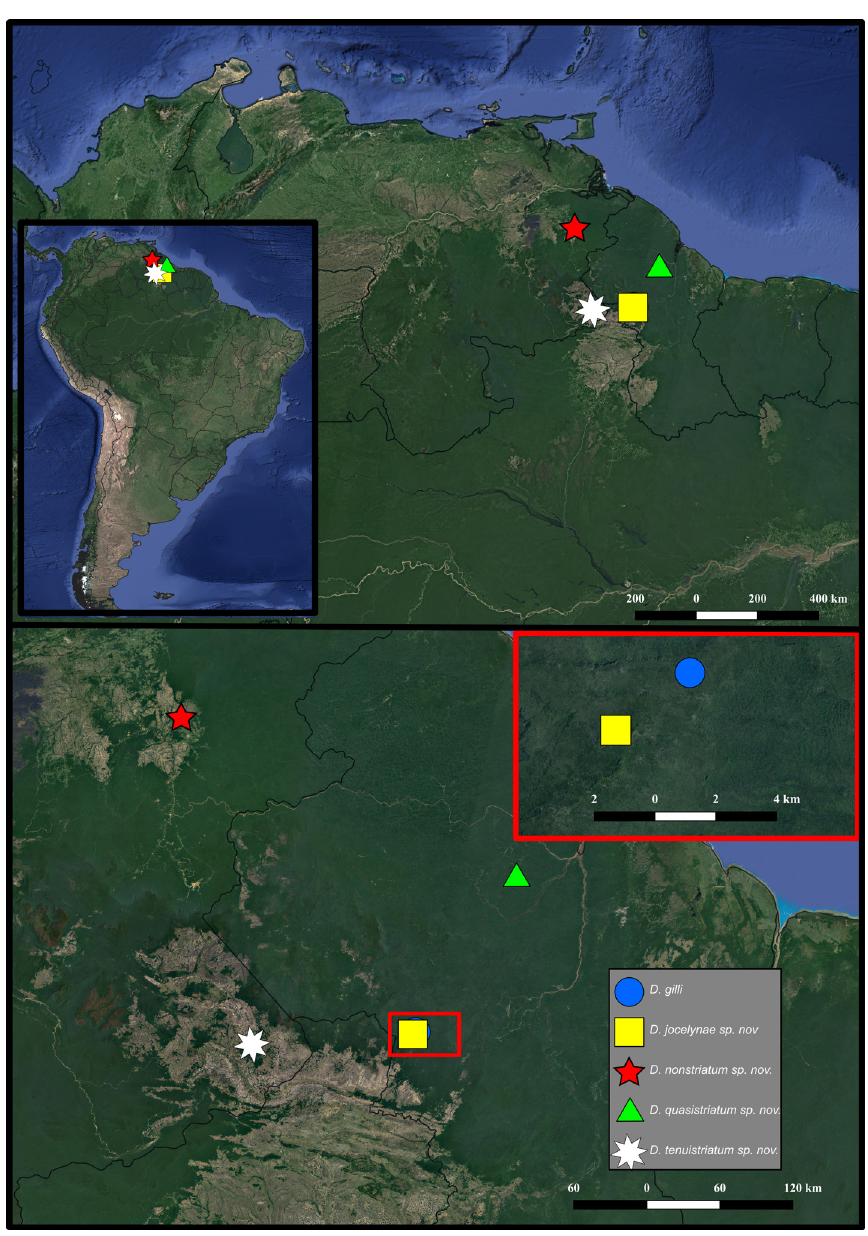
Fig. 10. Distribution map of the gilli species group. Blue circle = Deltochilum gilli González-Alvarado & Vaz-de-Mello, 2021; yellow square = D. jocelynae sp. nov.; red star = D . nonstriatum sp. nov.; green triangle = D . quasistriatum sp. nov.; white eight-point star = D . tenuistriatum sp.